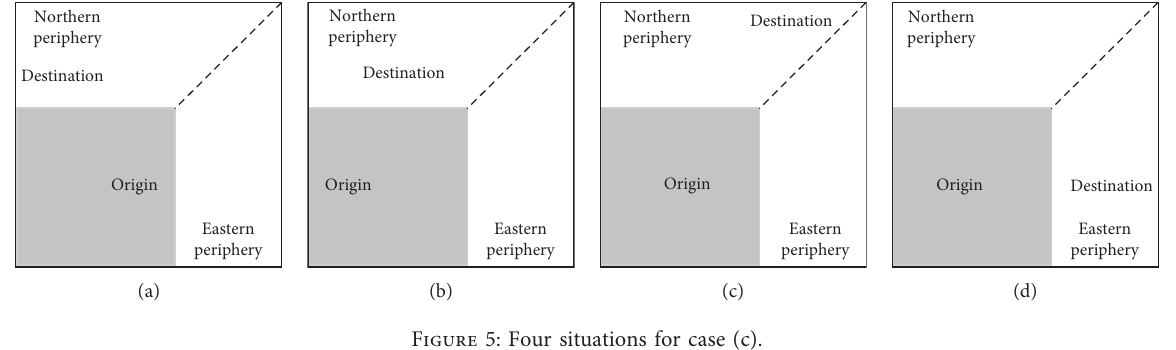
Figure 5: Four situations for case